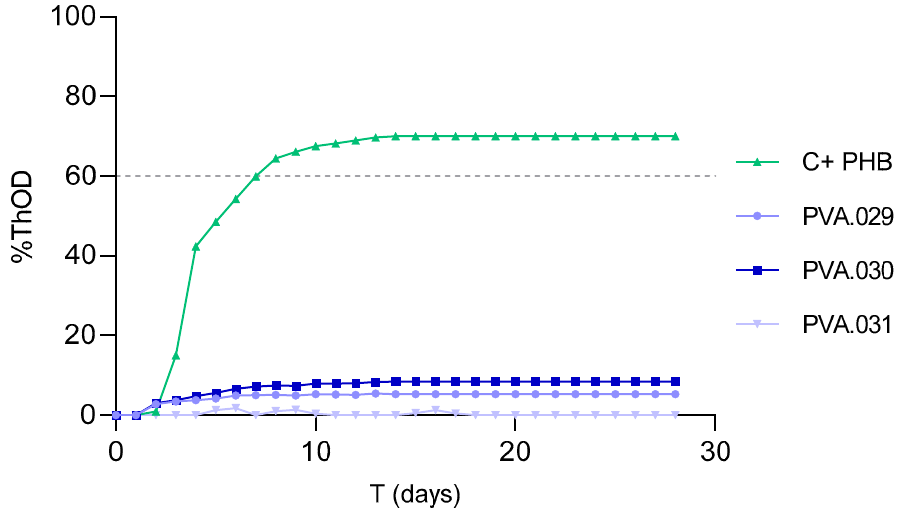
Figure 1. Biodegradation expressed by %ThOD for the different materials and the positive control (C+ PHB). Discontinuous line: 60% biodegradability threshold.